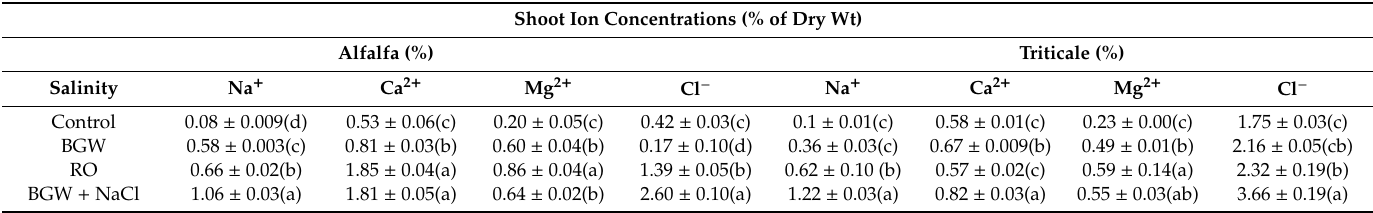
Table 2. E ff ect of irrigation water treatment on shoot ion concentrations (stems + leaves) of alfalfa and (stems + leaves + ear heads) of triticale at the conclusion of two runs conducted in sand soil. Means within columns sharing the same letter are not significant at α ≤ 0.05. Each observation is the mean ± SEs of four replications. The ECs of the saline treatments were as follows: control (0.7 dSm − 1 ), BGW (4 dSm − 1 ), RO (8 dSm − 1 ), and BGW + NaCl (8 dSm − 1 ).